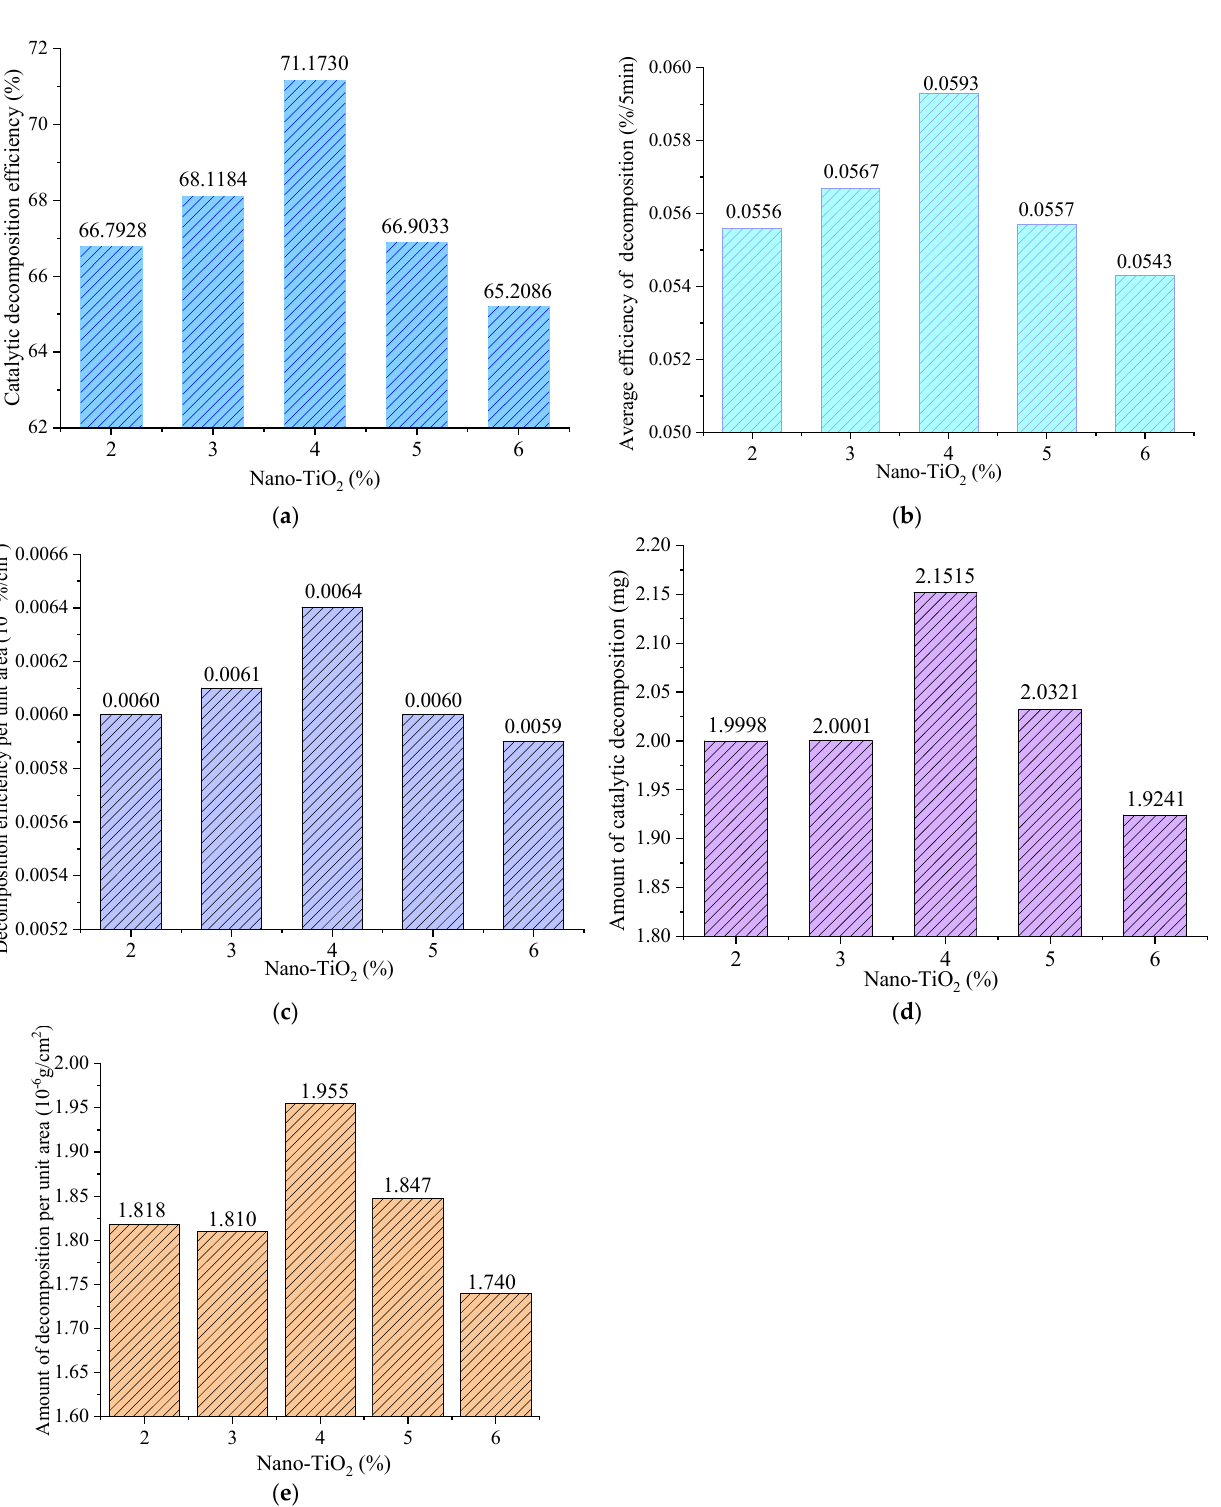
Figure 6. Catalytic evaluations with different contents of Nano-TiO 2. ( a ) Catalytic decomposition efficiency ( C ). ( b ) Average catalytic efficiency ( V c ). ( c ) Decomposition efficiency per unit area ( e ). ( d ) Amount of catalytic decomposition ( m ). ( e ) Amount of decomposition per unit area ( d ).